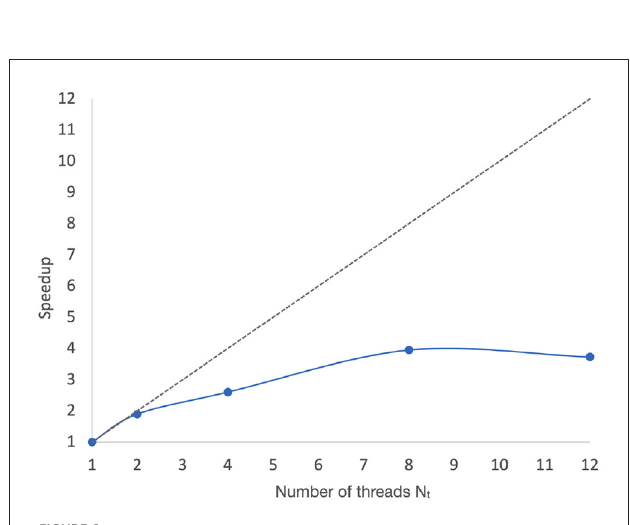
FIGURE6 Speedups associated with the data illustrated in Figure 5.